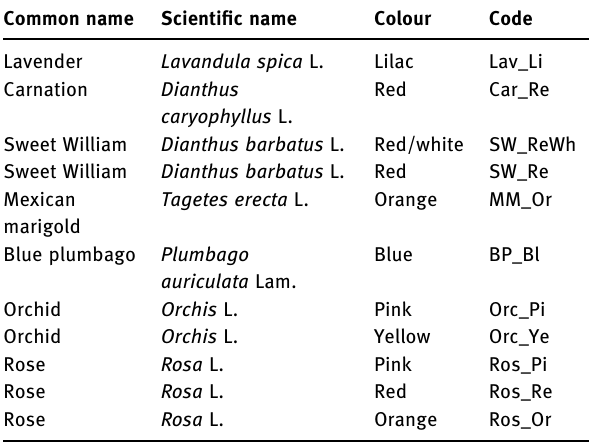
Table 1: Characteristics and codes of the fl owers used in the